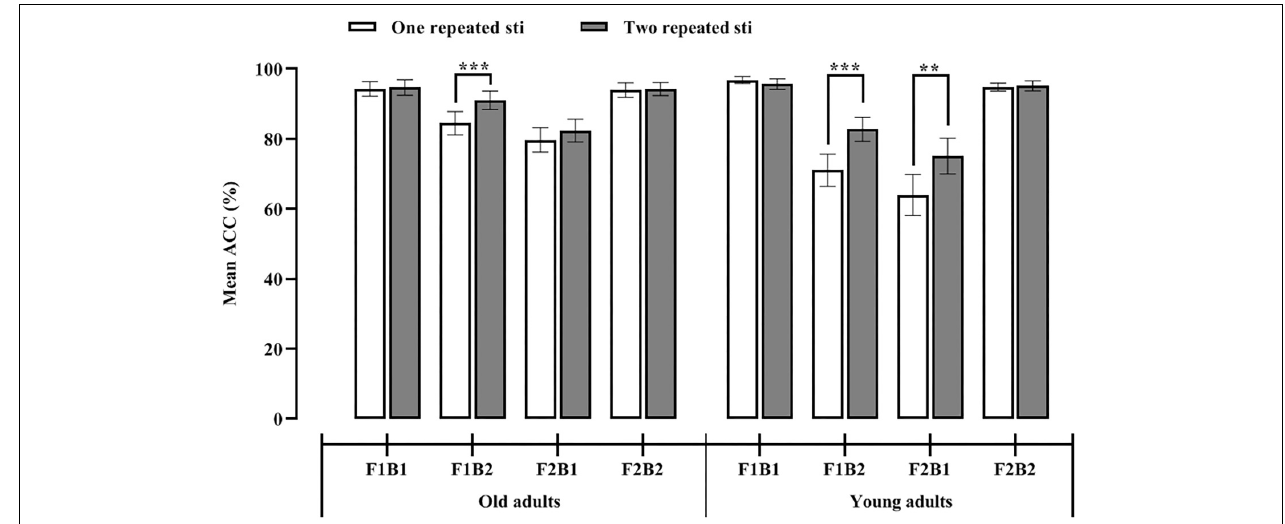
FIGURE 2 | Mean accuracy across all experimental conditions in old (left) and young (right)